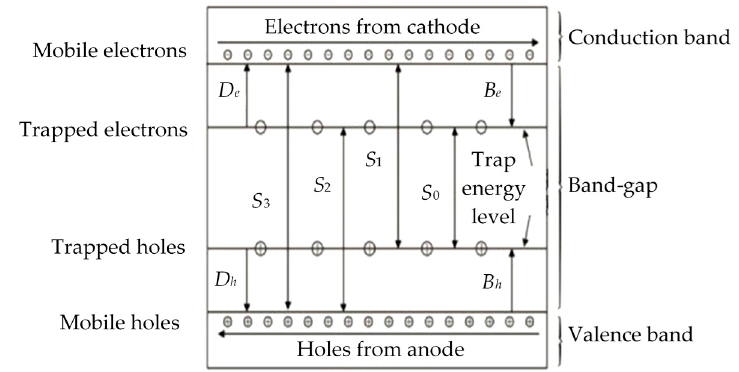
Figure 2. The mechanism of the bipolar charge transport (BCT) model [28].